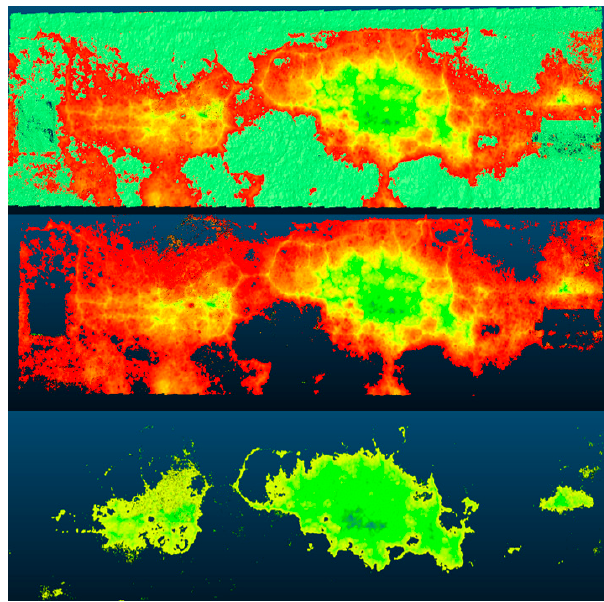
Figure 25. Segmentation of pavement section using RANSAC.